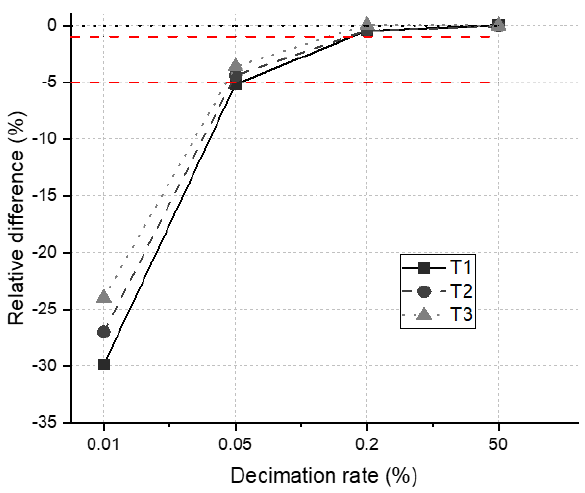
Figure 7. Relative difference of LAI for the various configurations. The dashed lines show the relative difference of − 1% and −